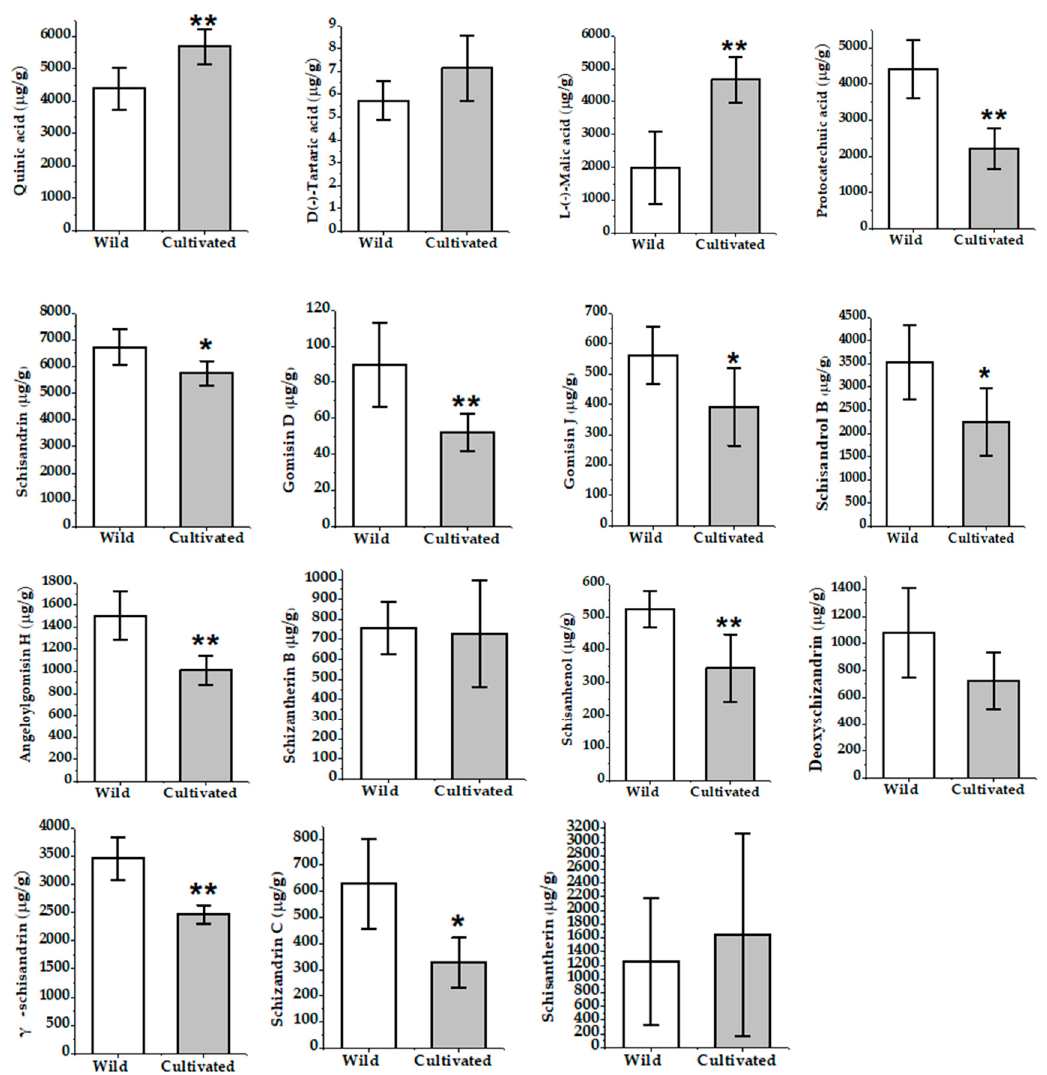
Figure 5. The contents of 15 compounds in wild and cultivated wuweizi (* p < 0.05; ** p < 0.01).